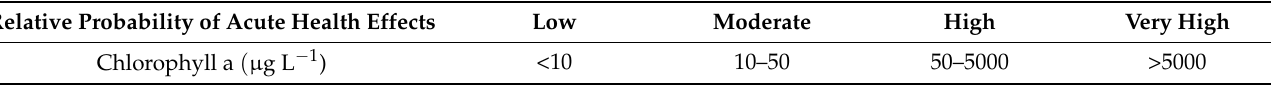
Table 1. WHO Recreational Guidance for Chlorophyll